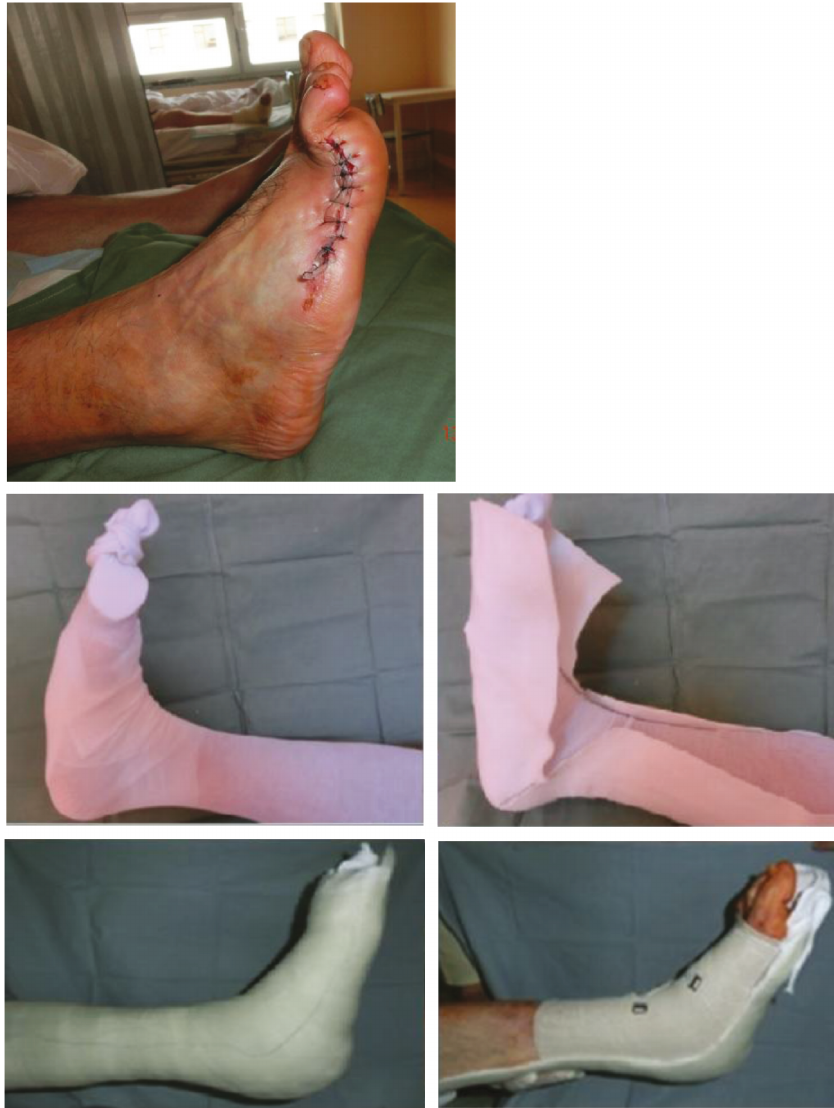
Figure 1: Removable contact splint